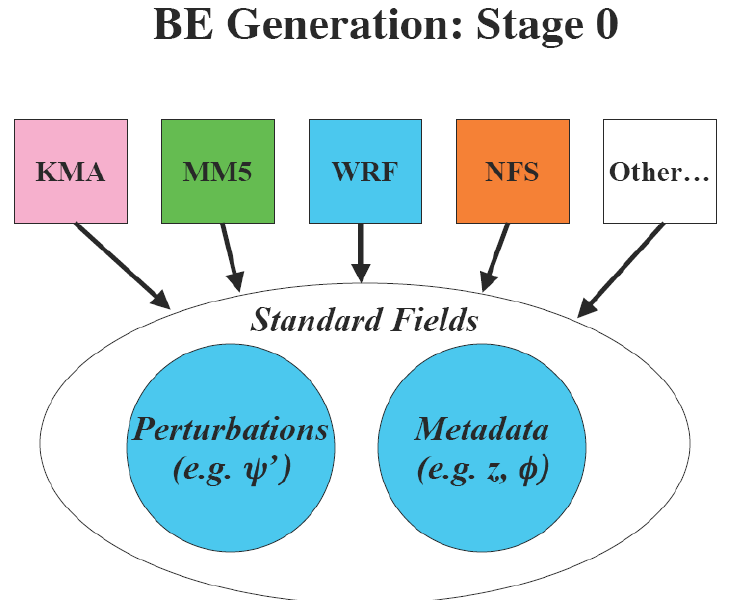
Figure 9.2: Sketch of the role of Stage 0 converters in transforming model-specific data (e.g., ARW, KMA global model, etc.) to standard perturbation fields and relevant metadata (e.g., latitude, height, land/sea,